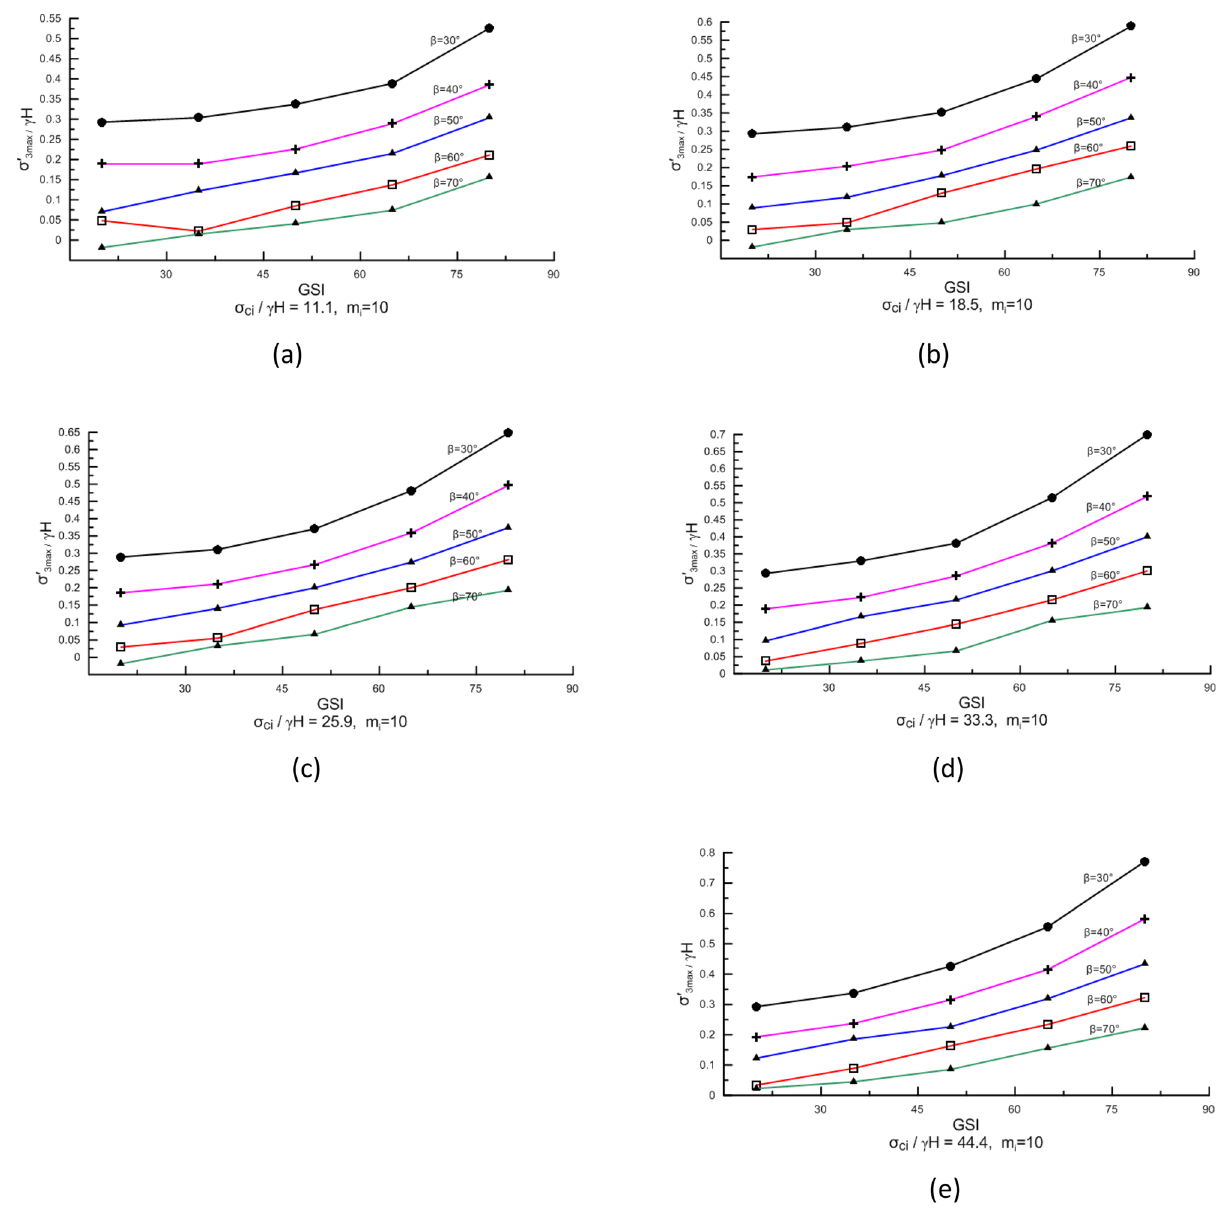
σ ′ 3,max γ H and GSI.